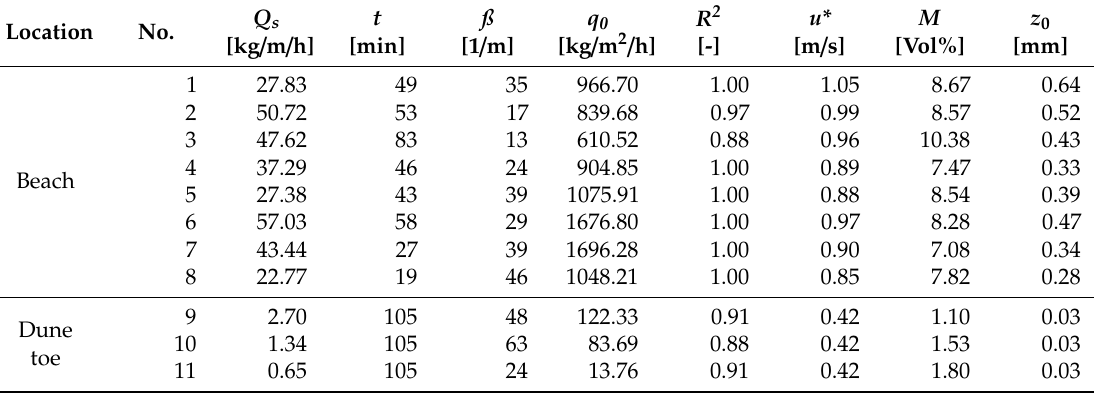
Table 2. Results of the total mass flux over the measuring duration, decay rate, extrapolated saltating sediment mass transport at the surface, correlation coefficients of the regression analysis of the vertical wind profile (rounded values), shear velocity, moisture content, and aerodynamic roughness length. Location No.